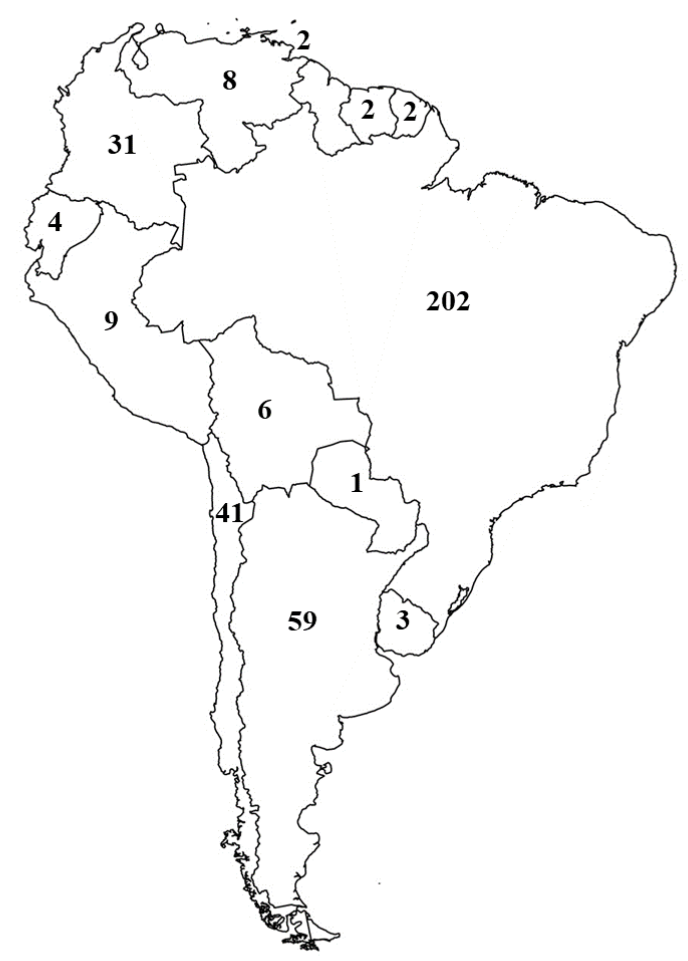
Figure 3. Number of papers in the last ten years in South